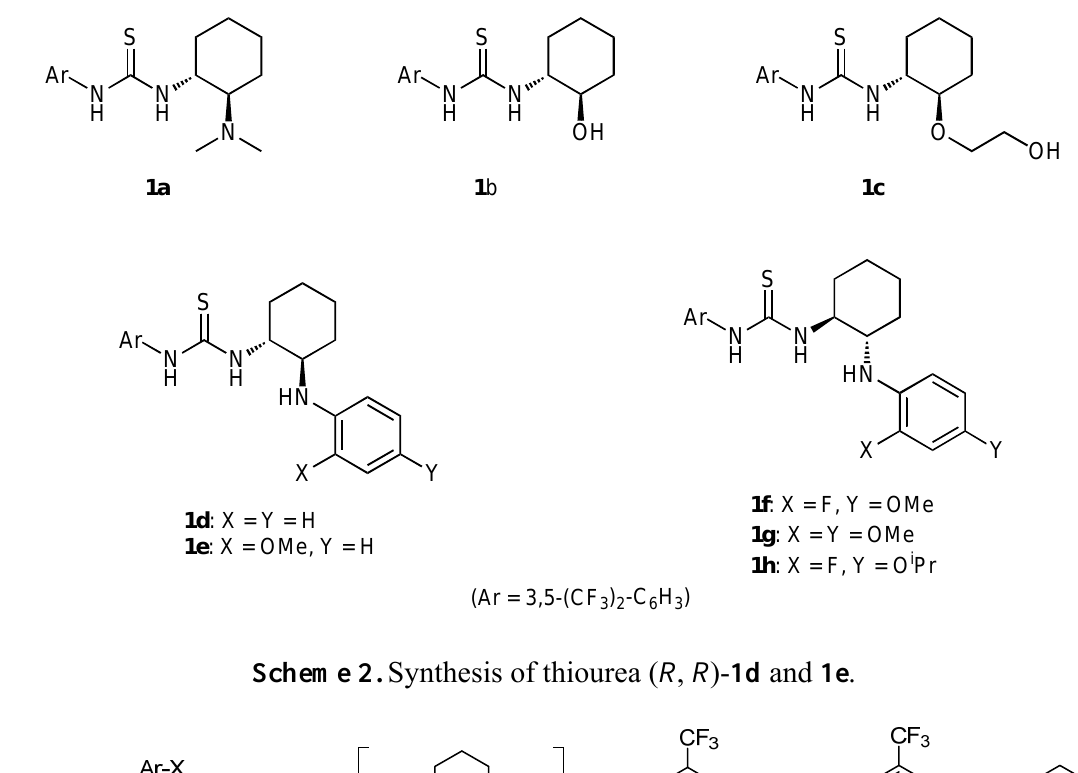
Figure 2. Structures of thiourea catalysts